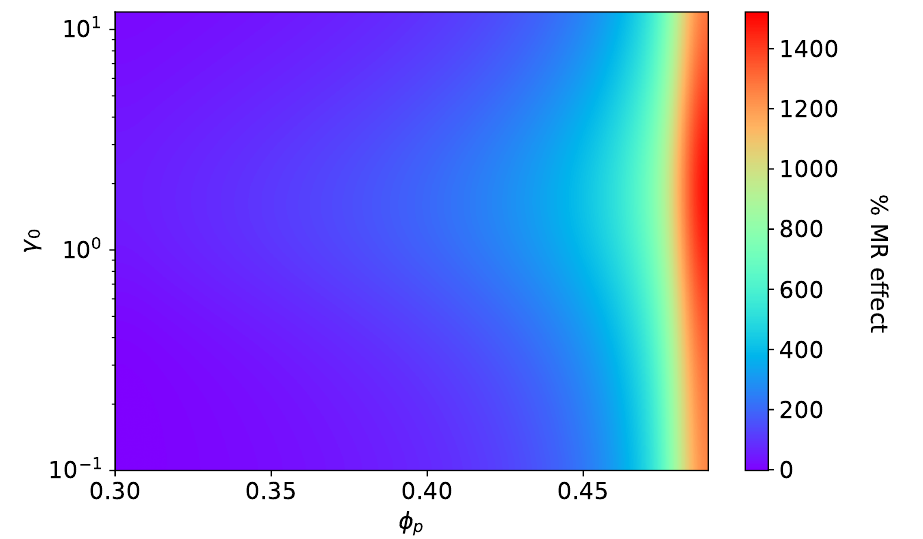
Figure 10. The magneto-rheological effect: Transition of isotropic MAE to anisotropic MAE with smeared columns at | (cid:126) H 0 | = 470 kA/m, G m = 17 kPa, φ =